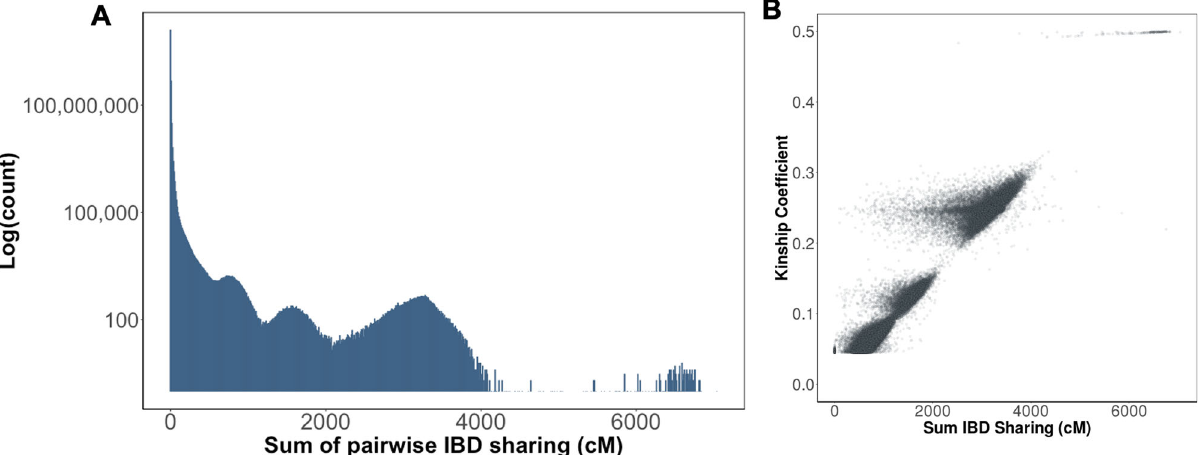
Fig. 5 Identity-by-descent sharing in the UK biobank. A Distribution of the sum of pairwise IBD sharing (cM) in the UK Biobank across all N = 487,330 participants. B Correlation between the sum of IBD sharing and kinship as measured by the KING software in all pairs of individuals reported in the UK Biobank output to be > = 3rd degree